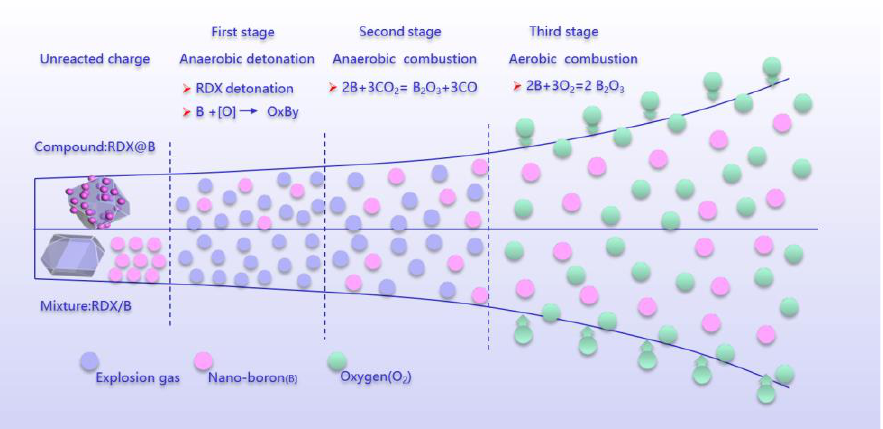
Figure 5. Illustration of implosion reaction diagram.